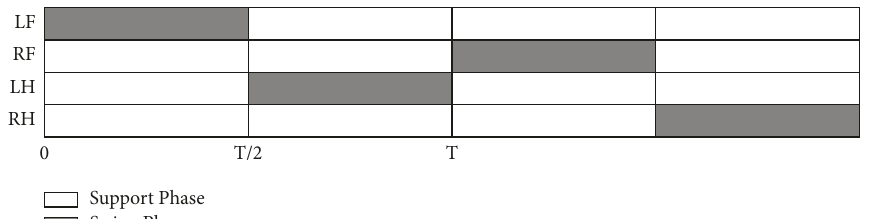
Figure 11: The timing diagram of the walking gait.